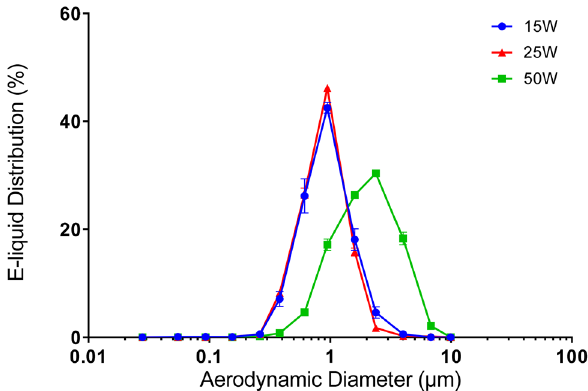
Figure 3. DLPI-collected data showing the effect of varying the power level on the frequency mass distribution of the e-liquid in an electronic cigarette. The results using the 15/25-W conditions (using low-power atomizer technology), and 50-W conditions (using high-power atomizer technology) are represented by a dot, triangle, and square, respectively. Experiments were carried out with an e-liquid composed of 50% propylene glycol and 50% vegetable glycerin with a nicotine concentration of 18 mg/mL (n = 5). DLPI DEKATI low pressure impactor, µm micrometers, mg/mL milligrams per milliliter, W watts.